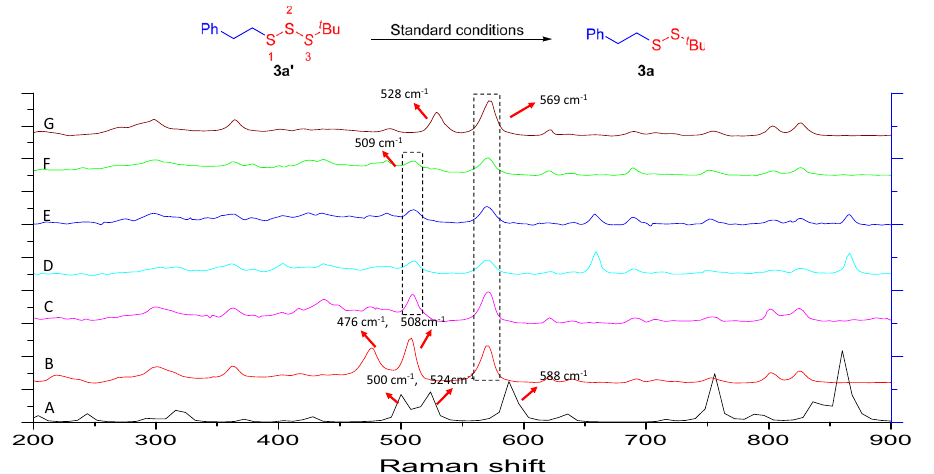
Fig. 8 Raman study (II). Raman spectra of (A) 3a ′ calculated data, (B) 3a ′ . (C) 3a ′ under optimized reaction conditions, t = 1 h, (D) 3a ′ under optimized reaction conditions, t = 4 h, (E) 3a ′ under optimized reaction conditions, t = 8 h, (F) 3a ′ under optimized reaction conditions, t = 12 h, (G) 3a